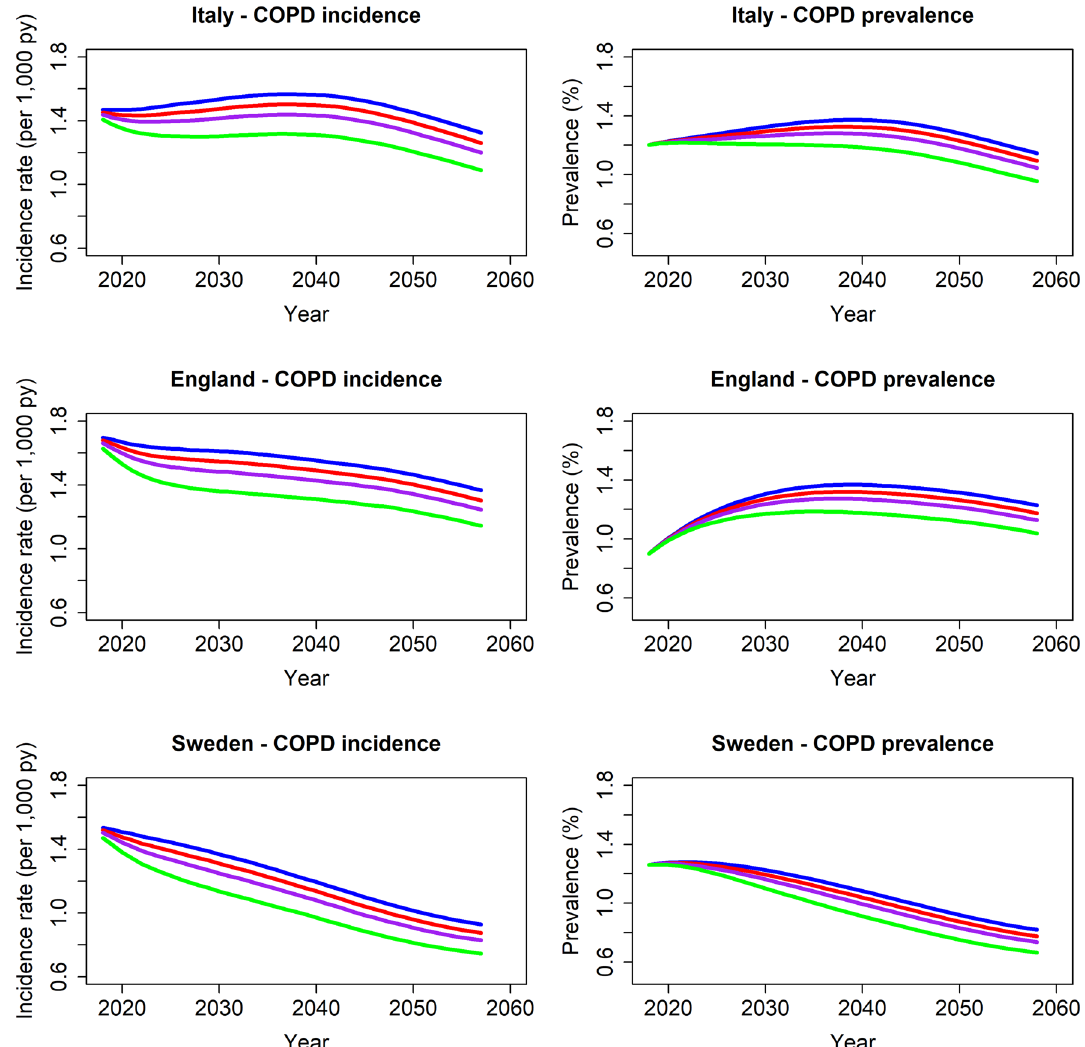
Figure 1. Projected COPD incidence (cases/1000 person-years) and COPD prevalence (%) over a 40-year time period in the various scenarios (blue: reference scenario; red, purple and green: 5%, 10% and 20% tobacco price increase, respectively). Figure created using the statistical program R (version 3.6.2, https ://www.R-proje ct.org).